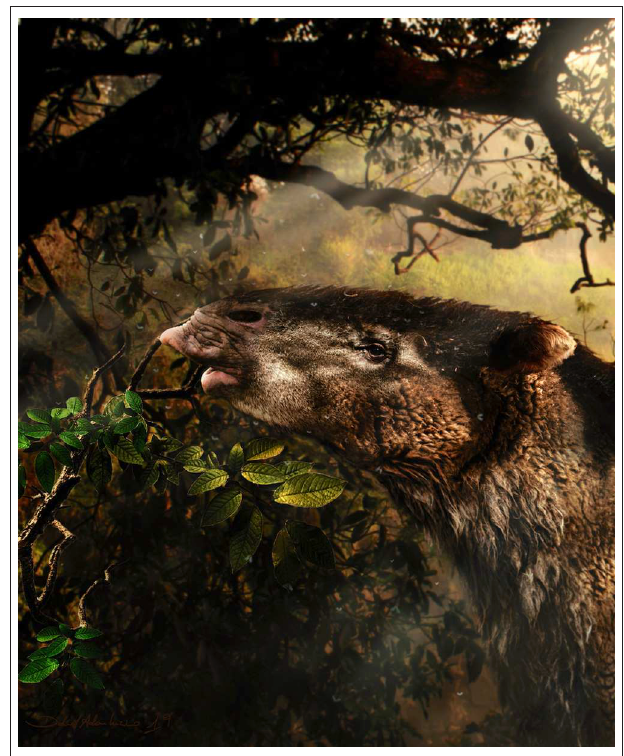
FIGURE 7 | Hypothetical life reconstruction of Catonyx tarijensis showing its inferred feeding behavior. The reconstruction is based on the skull MNHN-Bol V 13364 from the Pleistocene of Oruro (Bolivian Altiplano). Artwork by D. A.